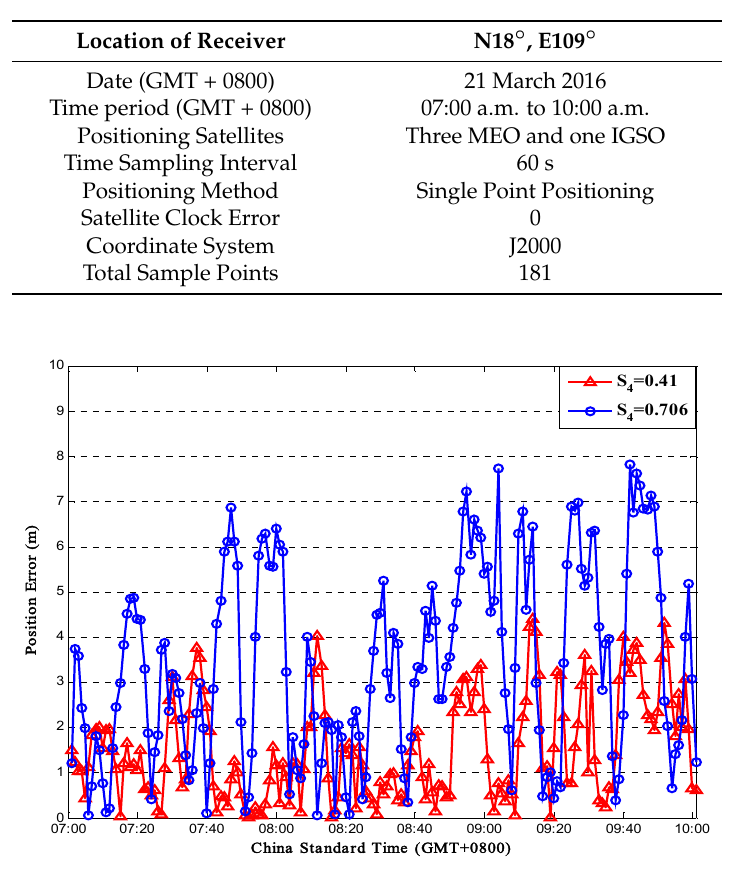
Figure 15. Positioning Accuracy for Sanya (N18°E109°).